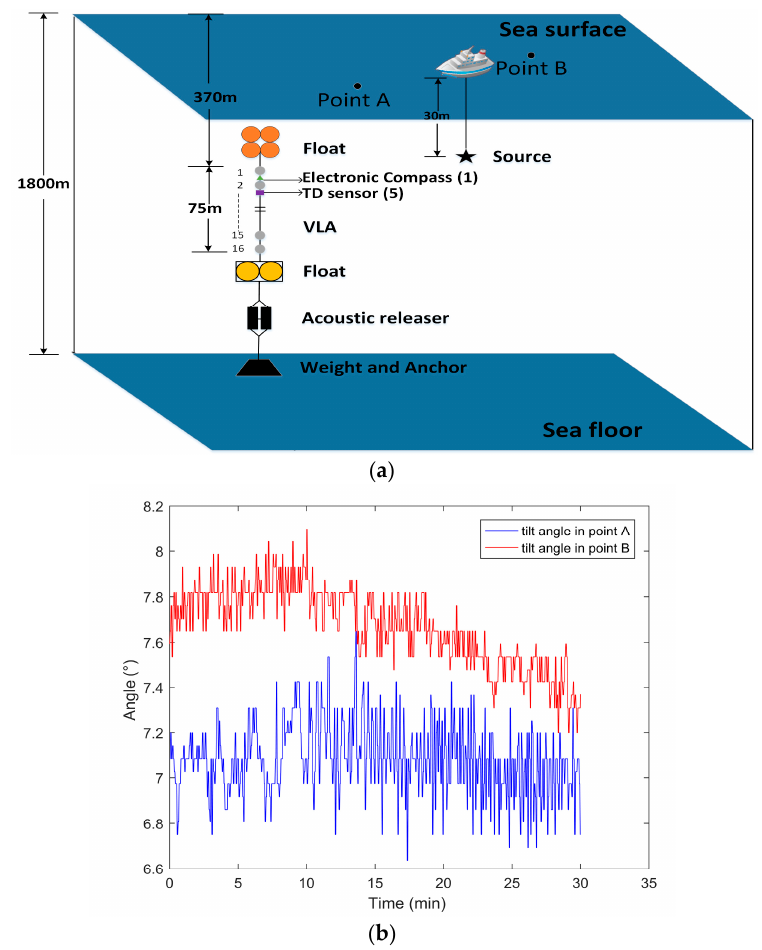
Figure 3. ( a ) Experiment configuration; ( b ) Tilt angles recorded by an electronic compass.